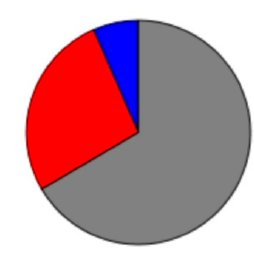
Figure 8. Viscum sample: SEM—live map.